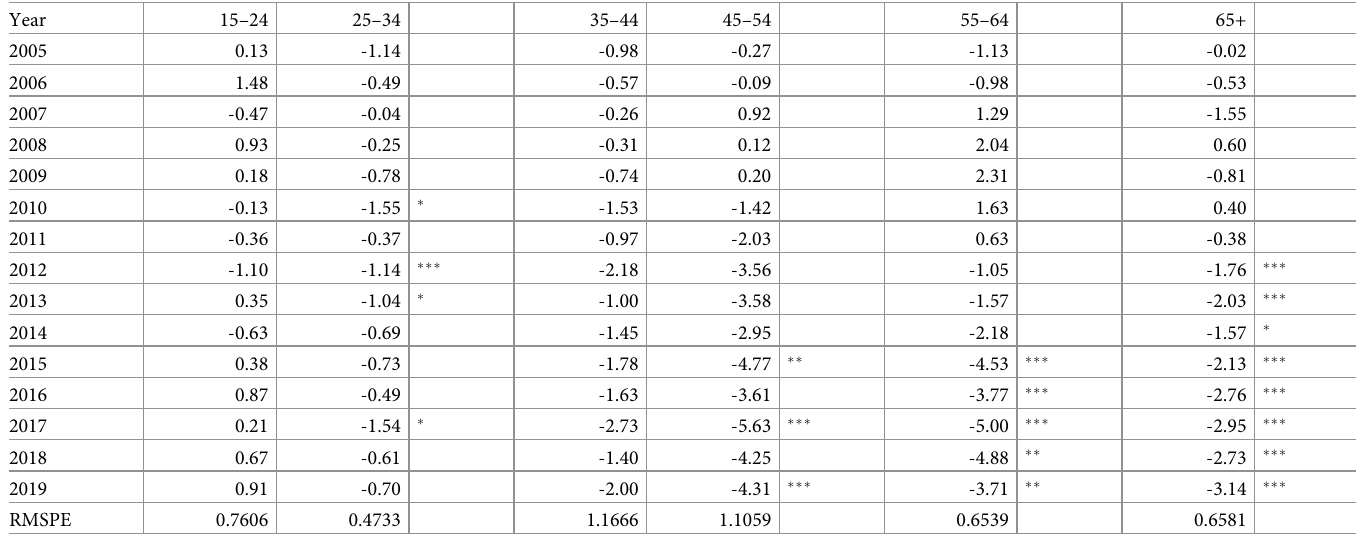
Table 3. Earmarked mental health tax effect on suicide mortality in California by age group,